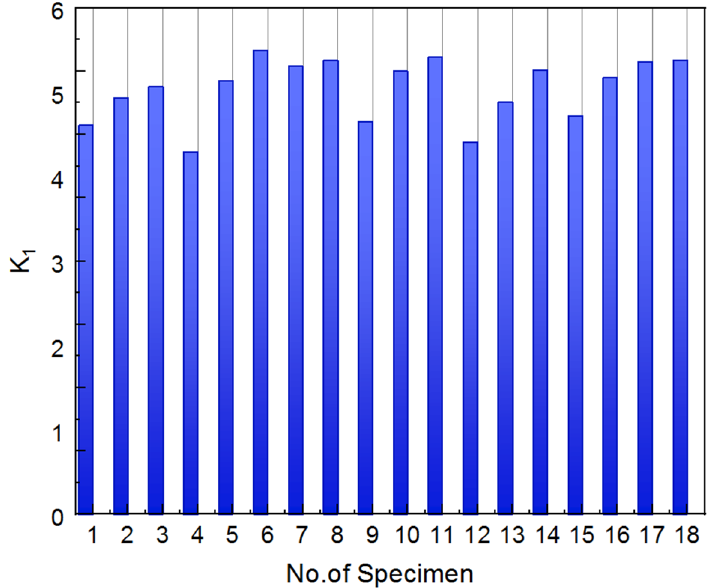
Figure 13. The calculated K 1 values of 18 different